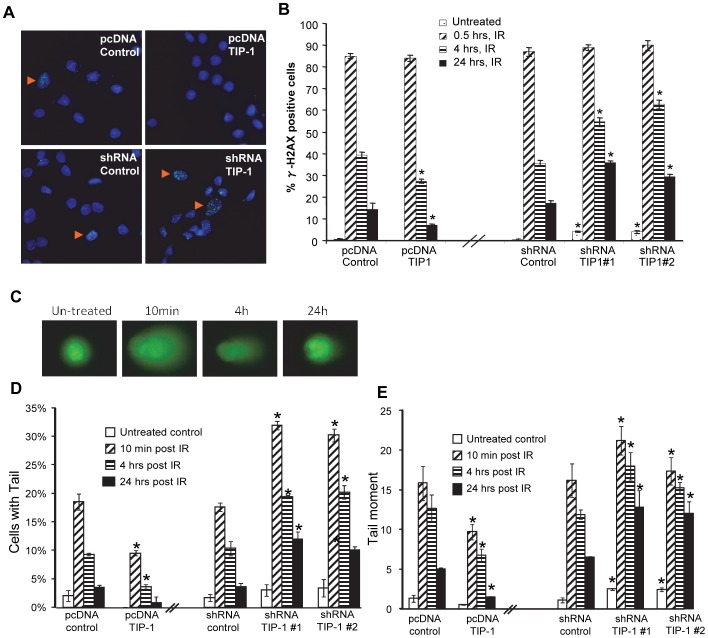
TIP-1 facilitates DNA damage repair after IR treatment.
A) γ-H2AX foci staining. D54 cells were mock treated or irradiated at 5 Gy, and γ-H2AX foci were detected by immunofluorescence staining at 0.5, 4 and 24 hours post the treatment. The representative images show positive cells (pointed with arrow heads) containing more than 5 foci. B) Percentage of γ-H2AX foci-positive cells was calculated upon at least 100 cells from each of the triplicate experiments. C) Representative images (×400) of IR-induced DNA damage visualized with neutral comet assay. D) Percentage of cells with comet tails (as one indicator of popularity of DNA strand breaks among cells). E) Statistics of tail moments (as one indicator of DNA damage severity in individual cells). At least 75 comet images (including more than 100 cells) were analyzed for each group. Shown are the mean +/− standard deviation of at least three independent experiments. Significance was determined by comparing the denoted group to the respective vector control with the same treatment, respectively. * p<0.05, t-test.